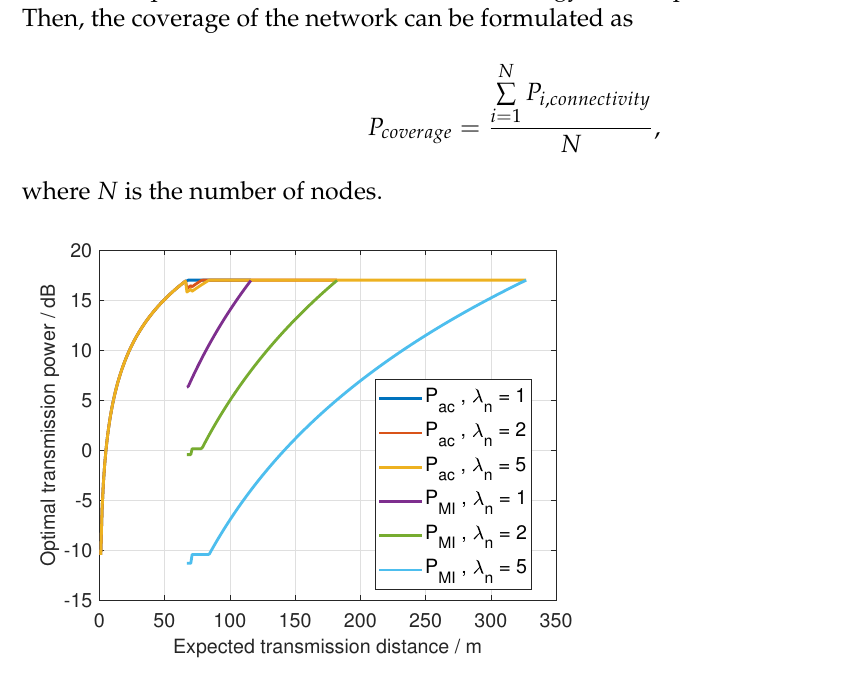
Figure 6. Transmission power of MI and acoustics under different system parameter